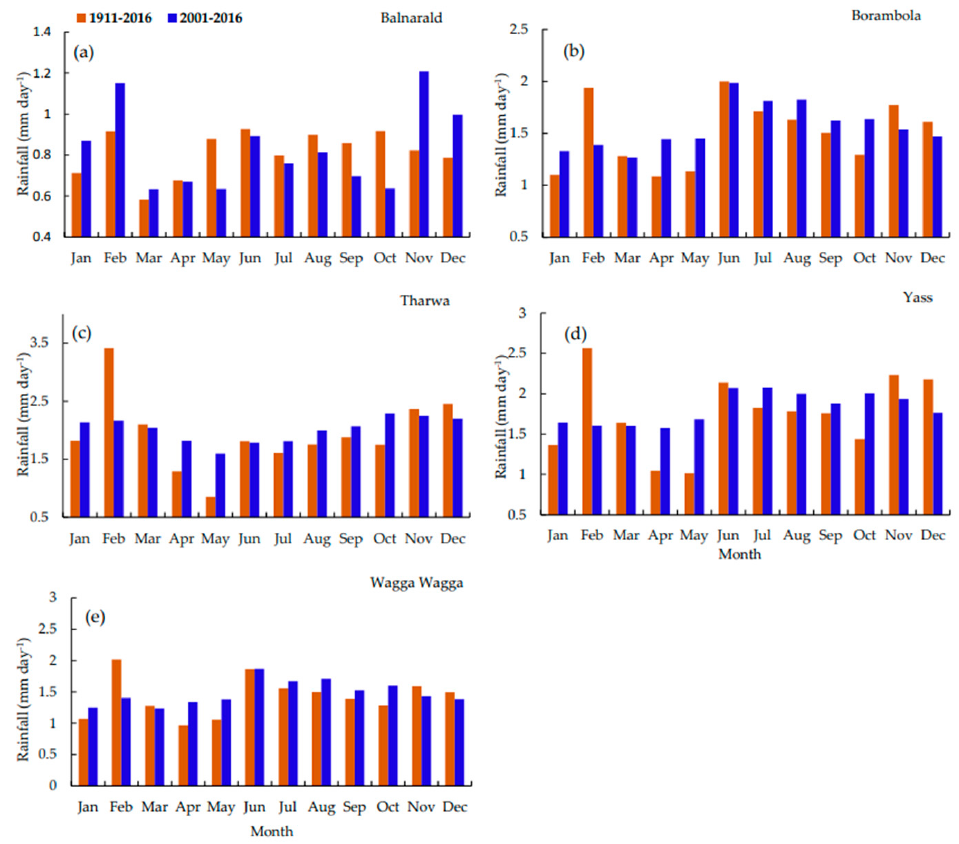
Figure 2. Long-term (1911–2016) and short-term (2001–2016) historical average rainfall plotted against five different sub-catchments. ( a ) Long-term and short-term historical average rainfall at Balranald, ( b ) Long-term and short-term historical average rainfall at Borambola, ( c ) Long-term and short-term historical average rainfall at Tharwa, ( d ) Long-term and short-term historical average rainfall at Yass, ( e ) Long-term and short-term historical average rainfall at Wagga Wagga.